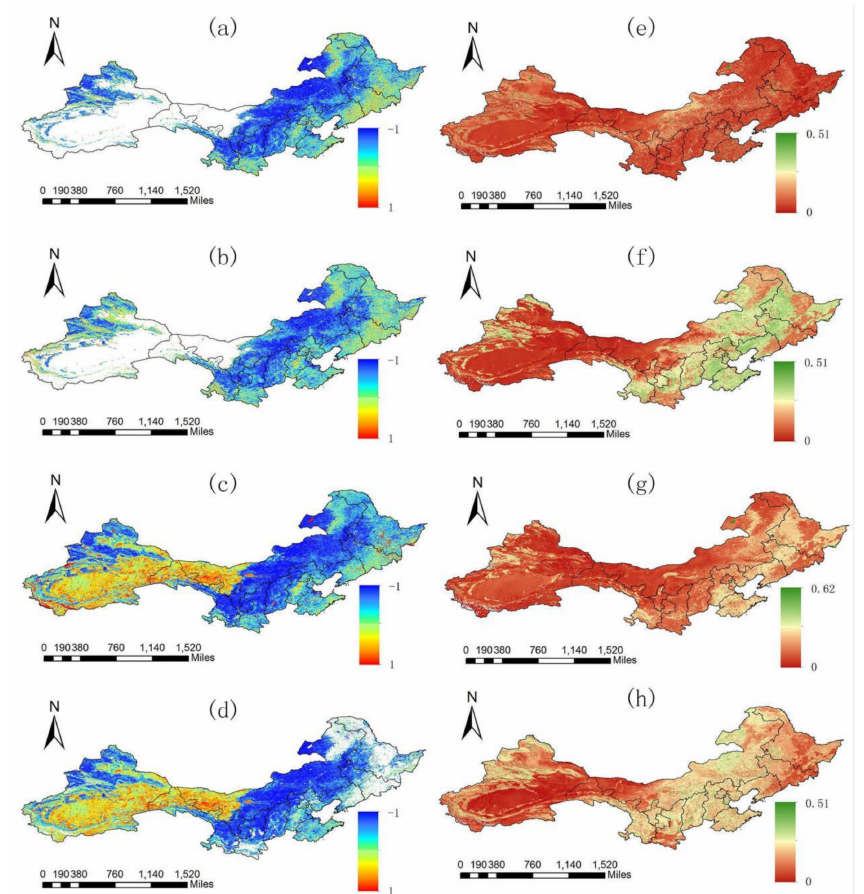
Figure 5. Correlation and root mean square error (RMSE) of each FVC data set with the averaged FVC from the three other FVC data sets used in this study. Left column is the correlation of ( a ) GLASS FVC, ( b ) TRAGL FVC, ( c ) GEOV1 FVC, ( d ) Li FVC with the average from the other FVC data sets. Right column is the corresponding RMSE value of ( e ) GLASS FVC, ( f ) TRAGL FVC, ( g ) GEOV1 FVC, ( h ) Li FVC with the average from the other FVC data